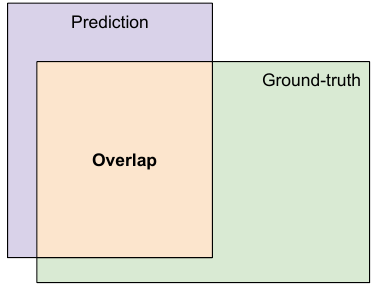
Figure 5. Intersection-over-Union (IoU) results from the ratio between the area of overlap between the predicted mask and the ground truth (intersection), and the total area occupied by them